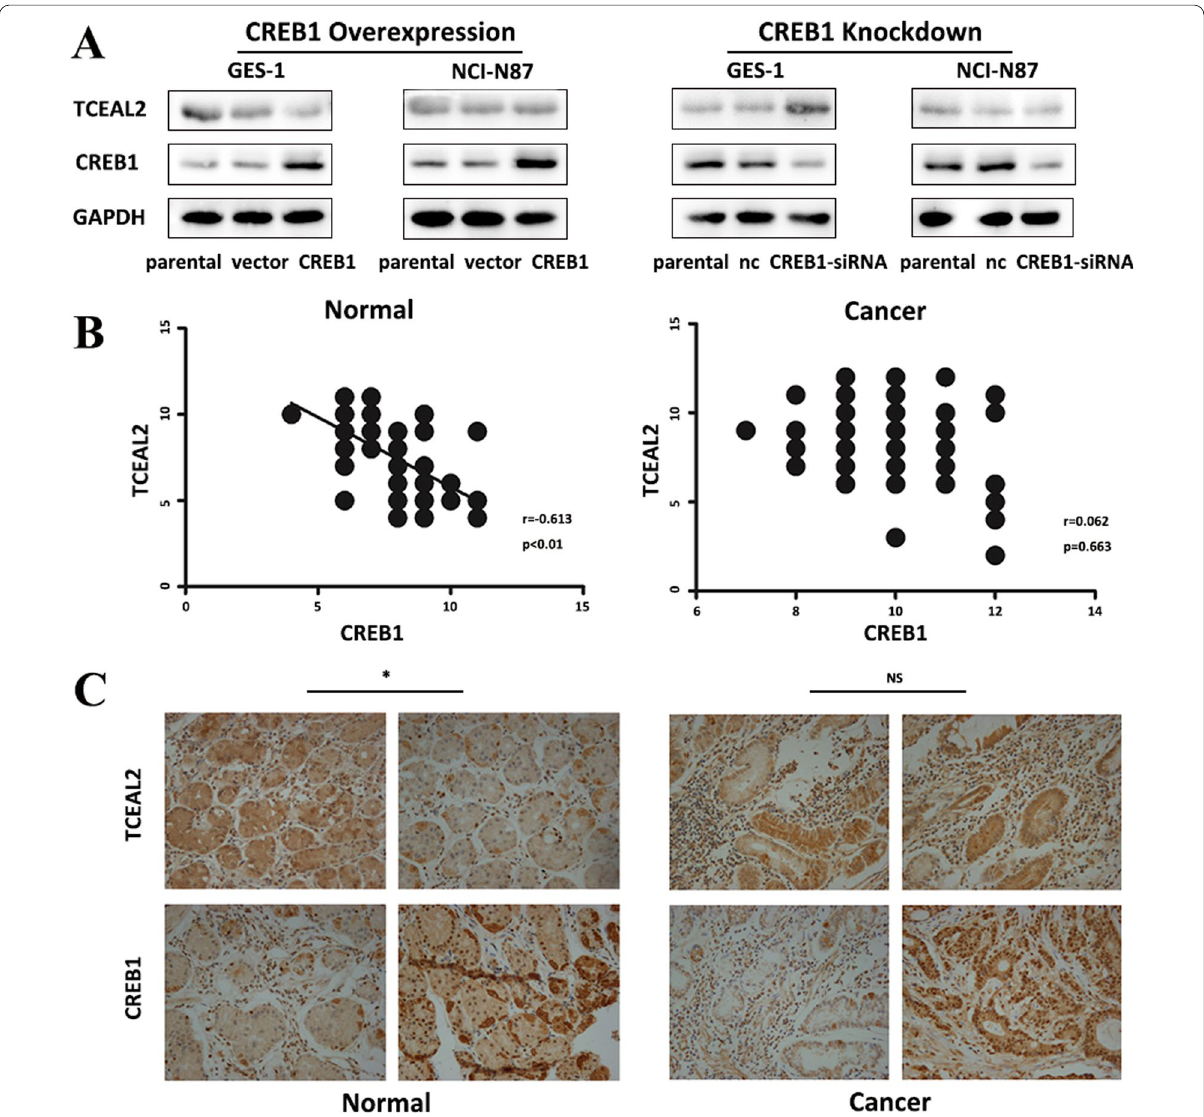
Fig. 4 CREB1 differentially regulated TCEAL2 under normal and cancer stages. A Western blot analysis for TCEAL2 expression was performed with cell lysate from GES‑1 and NCI‑N87 transfected with CREB1 lentivirus vectors (Left) or siRNA specific to CREB1 (Right). B Correlation between CREB1 and TCEAL2 in diagnostic tumor samples (n of CREB1 and TCEAL2 in tumor and normal samples (400 and TCAEL2 expression was analyzed by Spearman